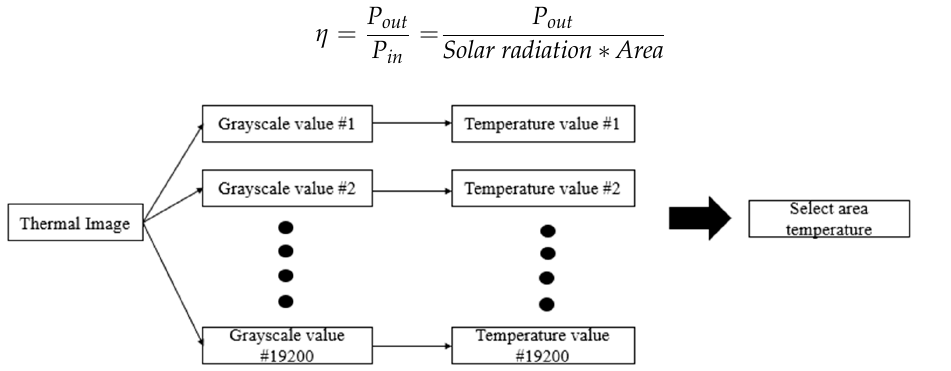
Figure 2. Regional temperature analysis. Table 4. SRCSolar XT-250P6B’s electrical properties and thermal